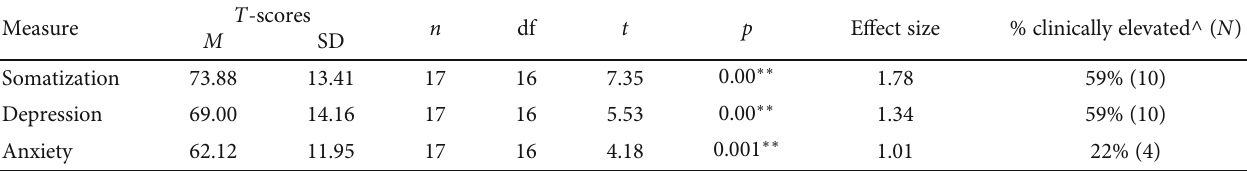
Table 5: Psychological